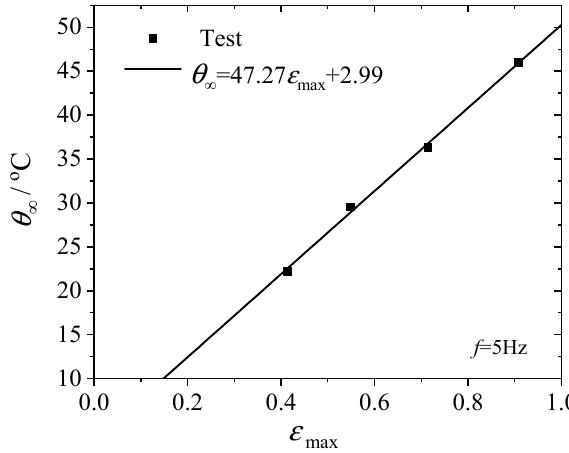
Figure 8. Steady state temperature increase of the hourglass specimen under fatigue with different ε max .